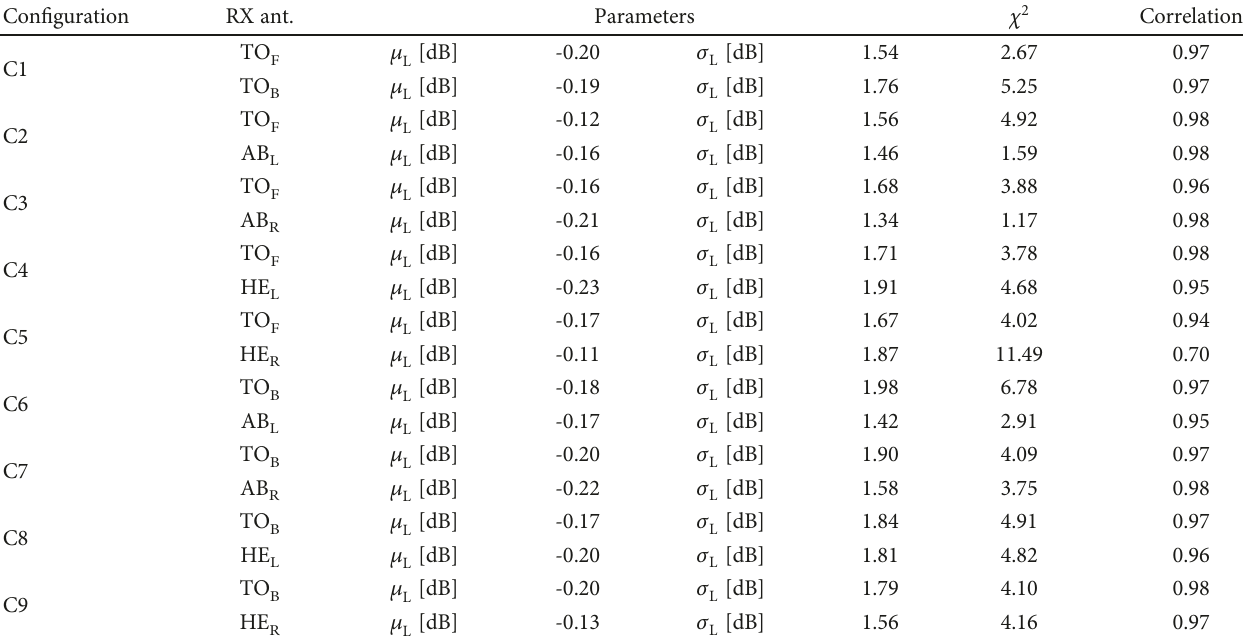
Table 4: Results of the lognormal distribution fi tting for the slow fading component and for all con fi gurations. Con fi guration RX ant.